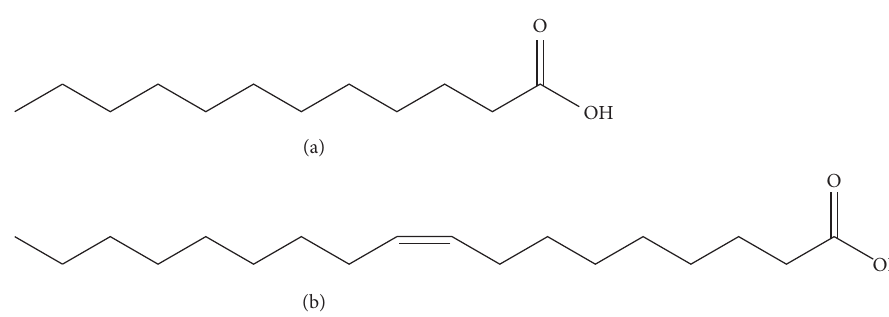
Figure 2: Structure of (a) lauric acid (C12 :0) and (b) oleic acid (C18:1).